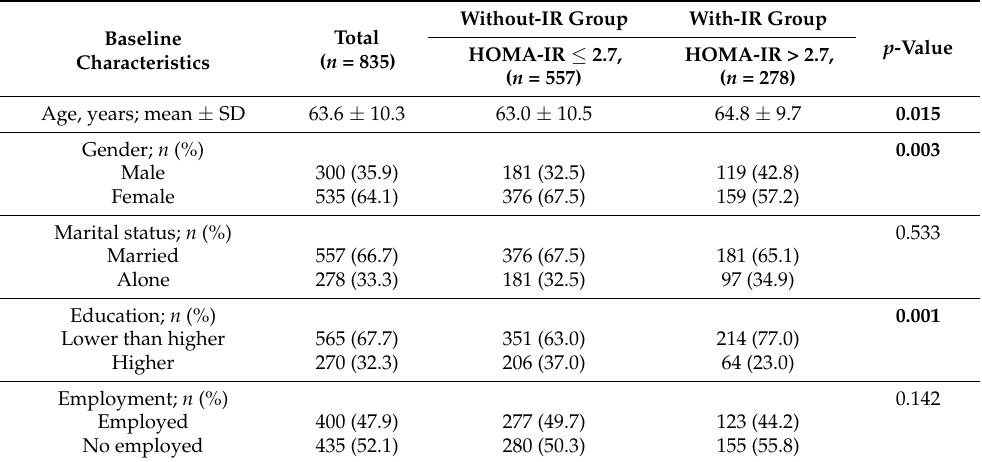
Table 1. The sociodemographic characteristics of subject groups without and with insulin resis- tance (IR).